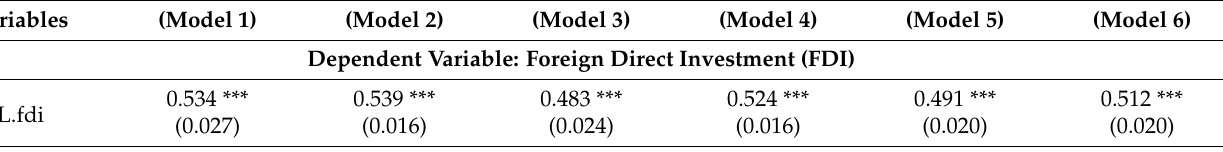
Table 5. Empirical estimates of the relationship between infectious diseases and FDI (removing